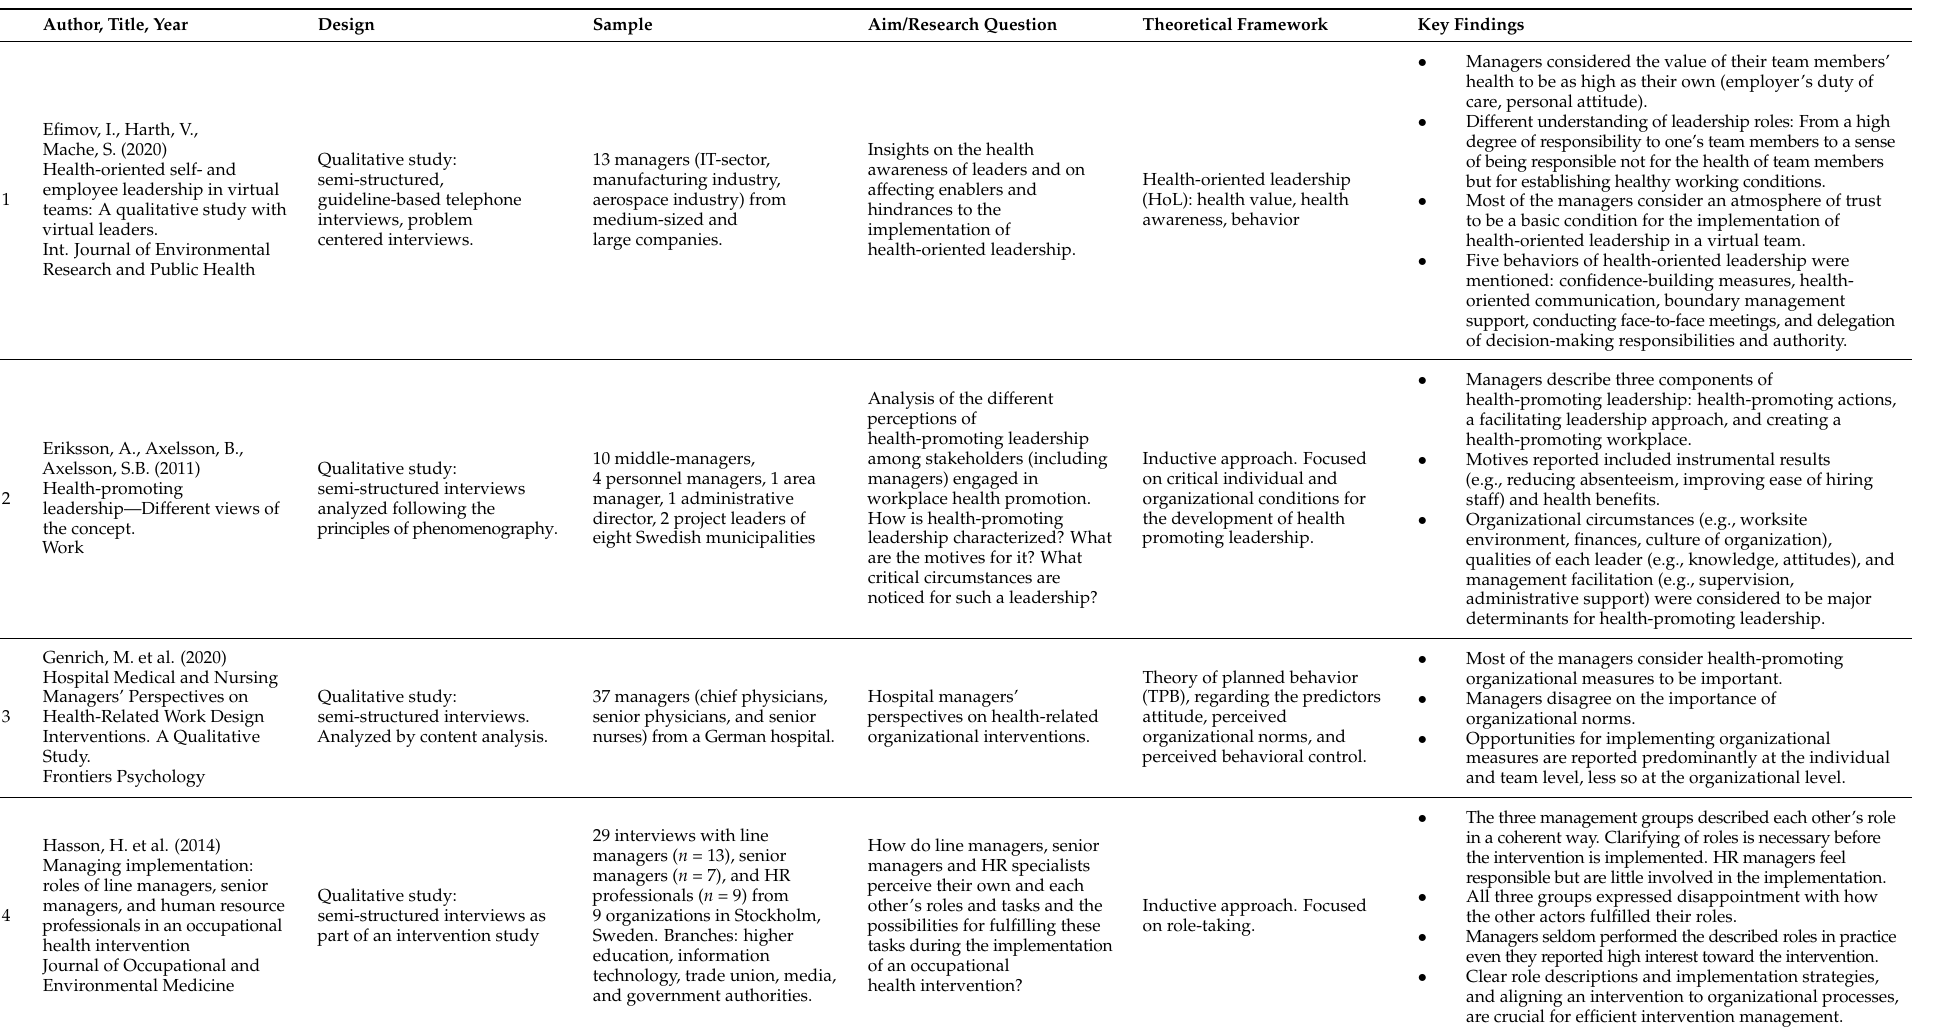
Table 1. Overview of included